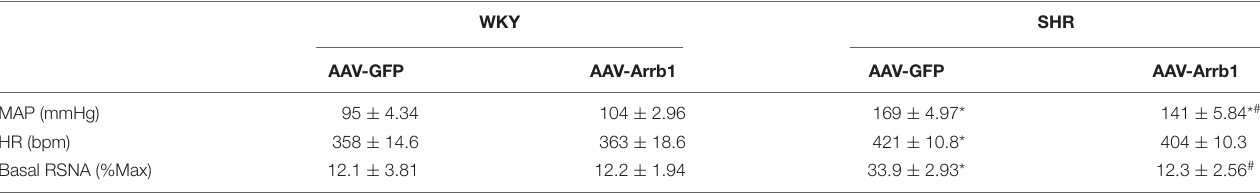
TABLE 1 | Baseline levels of MAP, HR, and RSNA in anesthetized rats 2 weeks after transfection with AAV-GFP or AAV-Arrb1 in the RVLM. WKY SHR AAV-GFP AAV-Arrb1 AAV-GFP AAV-Arrb1 MAP (mmHg) 95 ± 4 . 34 104 ± 2 . 96 169 ± 4 . 97 * 141 ± 5 . 84 * # HR (bpm) 358 ± 14 . 6 363 ± 18 . 6 421 ± 10 . 8 * 404 ± 10 . 3 Basal RSNA (%Max) 12 . 1 ± 3 . 81 12 . 2 ± 1 . 94 33 . 9 ± 2 . 93 * 12 . 3 ± 2 . 56 # Values are presented as mean ± SEM. n = 5 per group, *P < 0.05 vs. WKY; # P < 0.05 vs. AAV-GFP. MAP, mean arterial pressure; HR, heart rate; bpm, beats/min; RSNA, renal sympathetic nerve activity; RVLM, rostral ventrolateral medulla; WKY, Wistar-Kyoto; SHR, spontaneously hypertensive rat; AAV, adeno-associated virus; GFP, green fluorescent